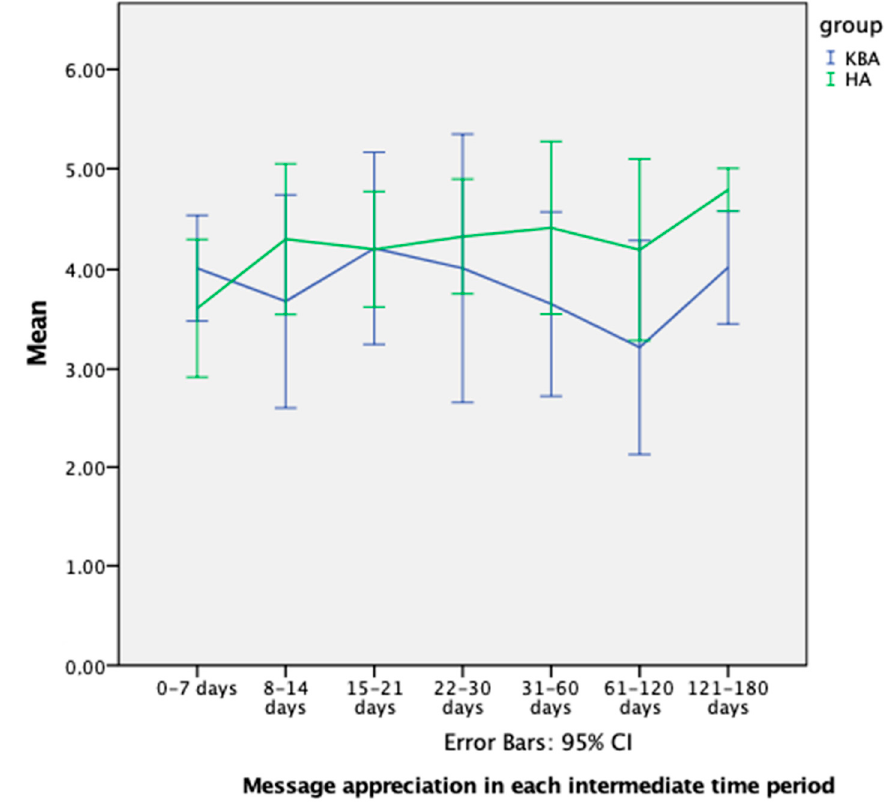
Figure 3. Evolution of the message appreciation (a higher score is a higher appreciation).